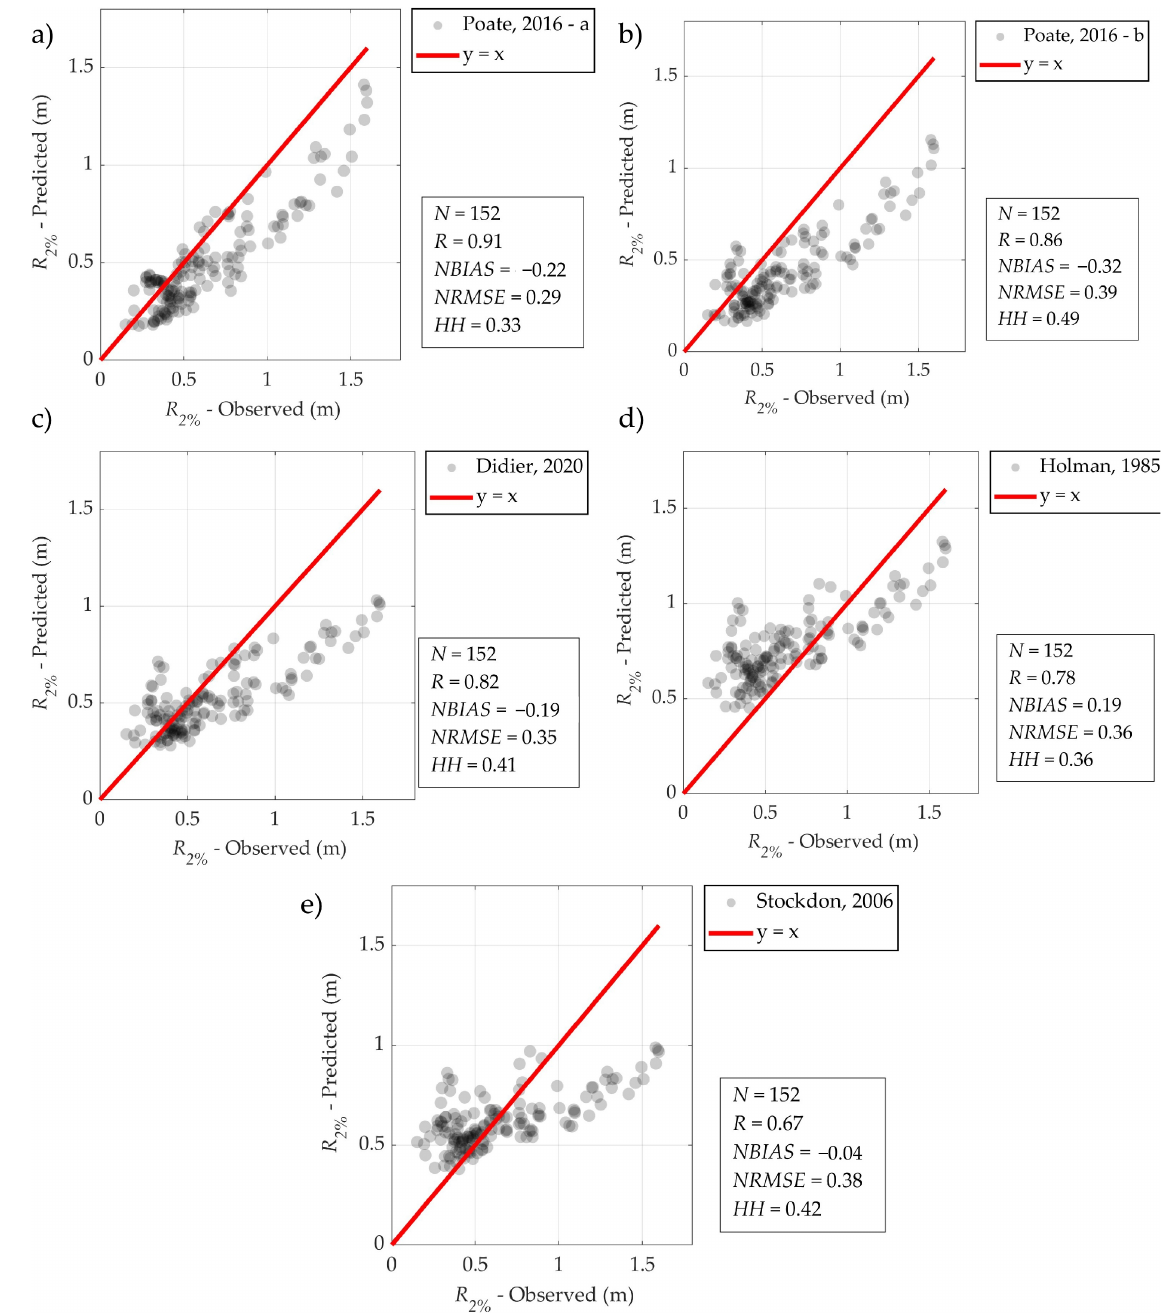
Figure 7. Comparison between observed runup values of fetch-limited pocket gravel beach Plo č e and those predicted using the formulae outlined in Appendix B: ( a ) P16a, ( b ) P16b, ( c ) D20, ( d ) H85, ( e )